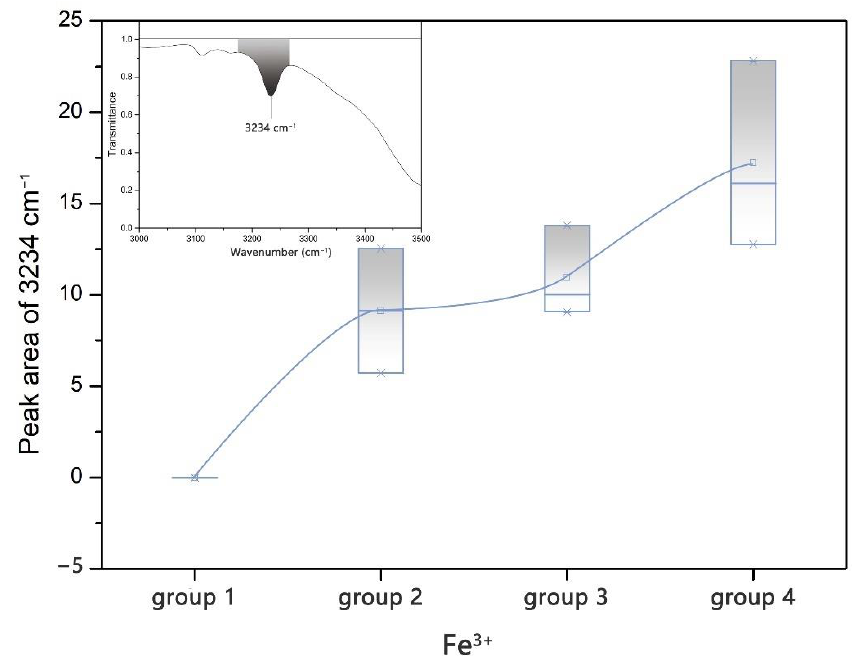
Figure 11. Fe 3+ was positively correlated with the area of the IR absorption peak area at 3234 cm −1 . The samples were divided into four groups by K-means clustering method, and each group of data was represented by a box.